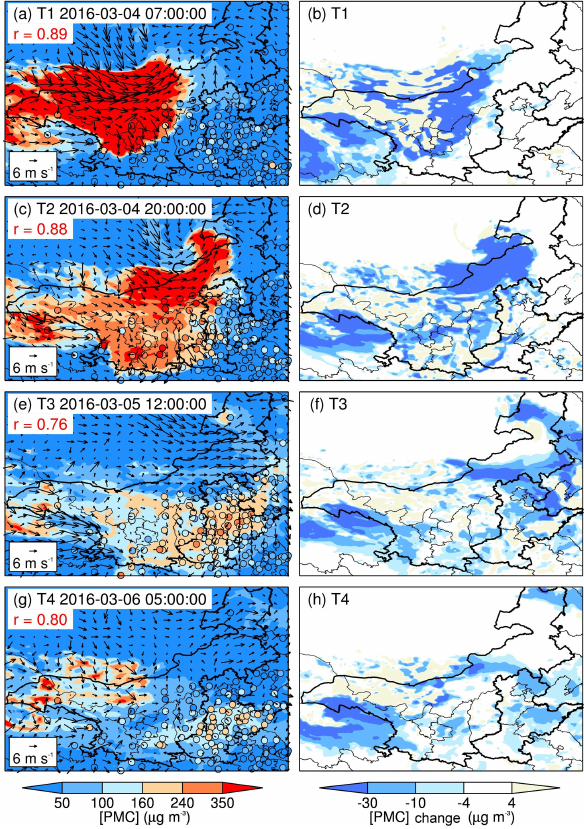
Figure 8. The horizontal distributions of surface [PMC] and [PMC] change at key time points of T1, T2, T3, and T4 (see Fig. 7). Pan- els (a, c, e, g) denote pattern comparisons of simulations vs. ob- servations for the REF case, as well as the correlation coefficient ( r ), along with the simulated wind field. Panels (b, d, f, h) refer to [PMC] change between the REF case and the SEN-ERPs case (REF –